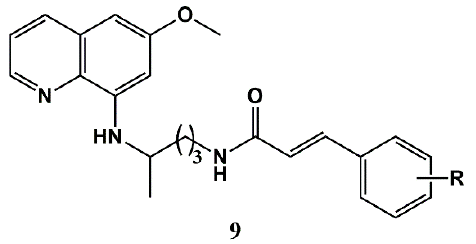
Figure 3. Primaquine-cinnamic acid conjugates proposed by Pérez et al. [61].